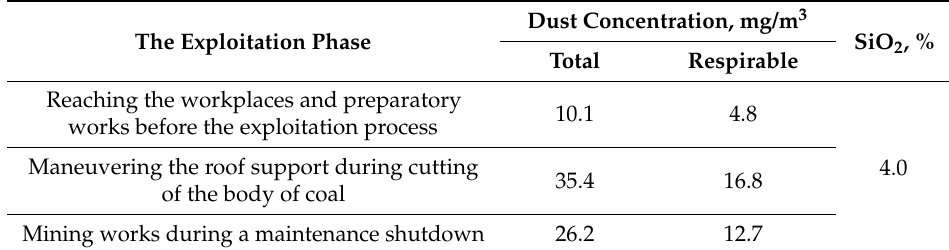
Table 10. The measurement results for the dust levels for selected activities, in the working position the miner working between the shearer and the air outlet from the longwall.